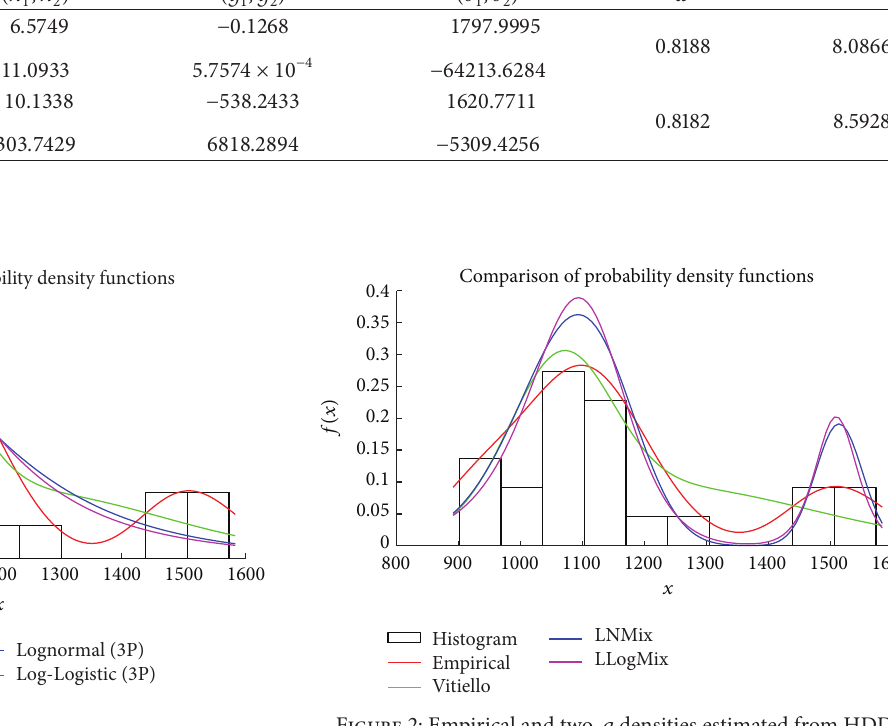
Figure 1: Empirical and LS ( Λ ) densities estimated from HDD. Figure 2: Empirical and two-